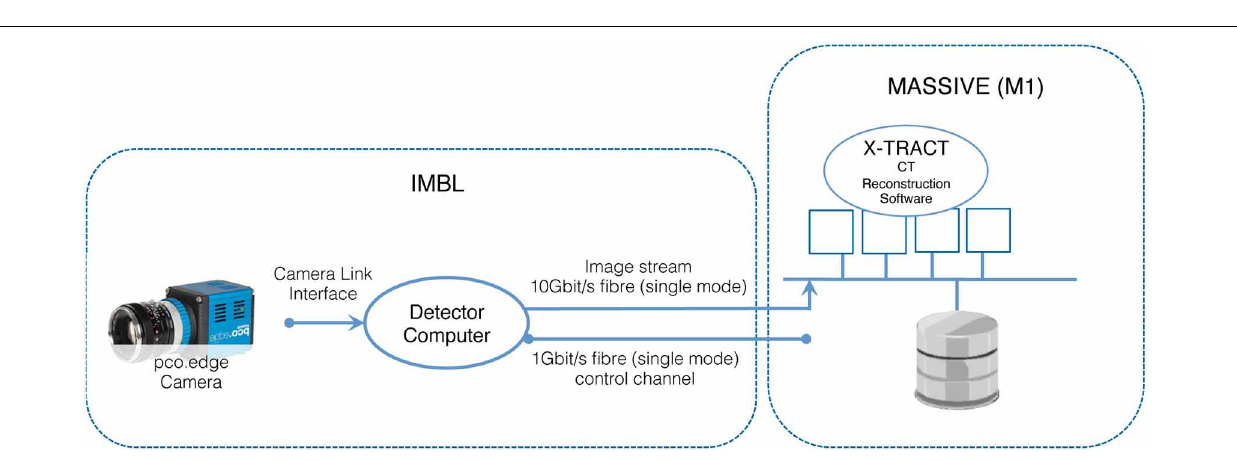
FIGURE 4 | Schematic of the architecture of the IMBL CT Reconstruction service provided on